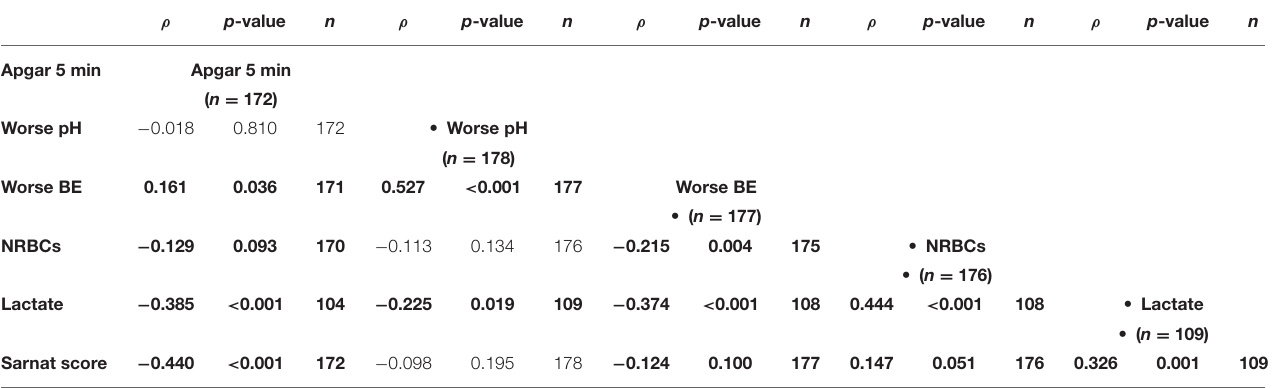
Analysis by Spearman ρ correlations. BE, base excess; NRBCs, nucleated red blood cells. Bold represent p-values <